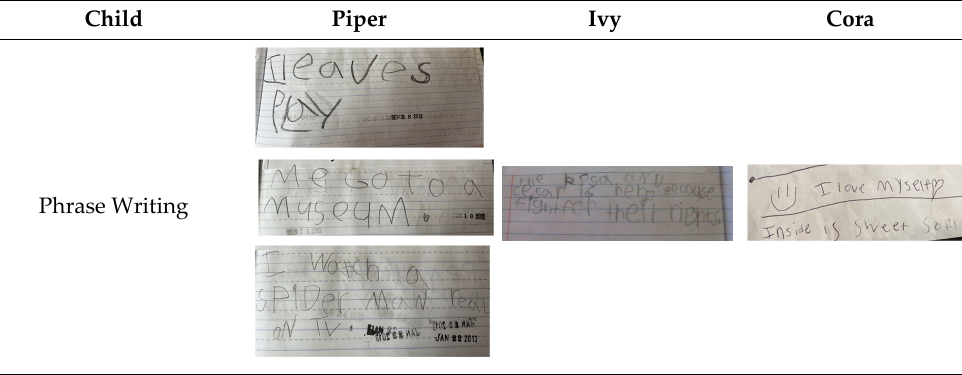
Table 4. The Conventional Stage.